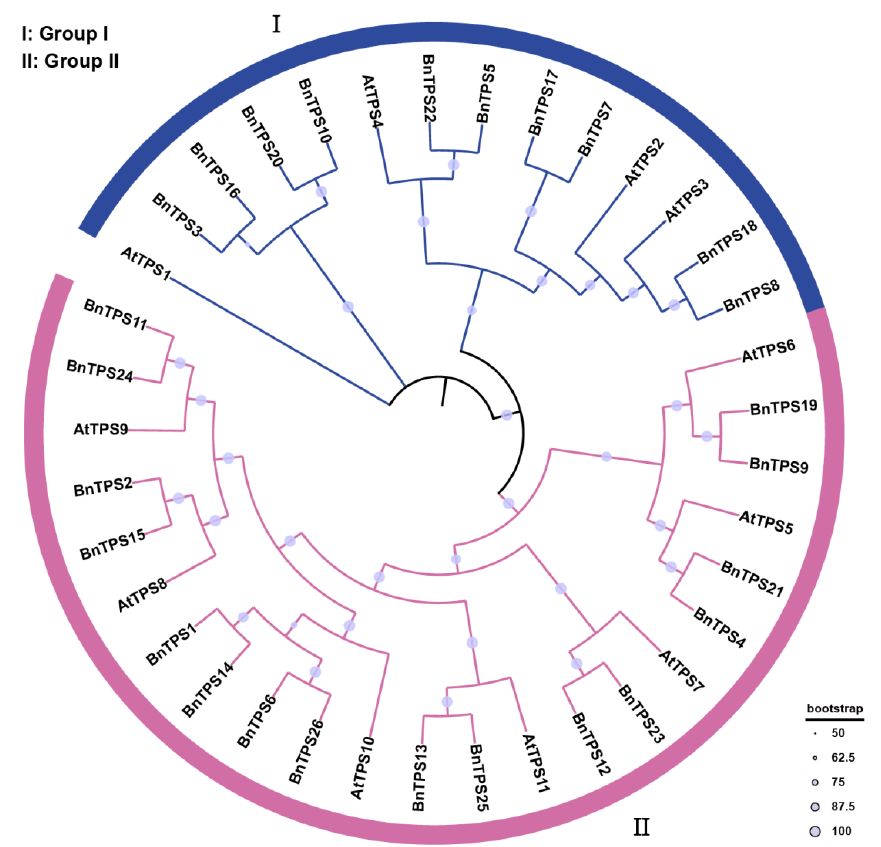
Figure 1. A phylogenetic tree of BnTPS and AtTPS genes. All TPS genes were classified into two groups and different colors represent two groups.